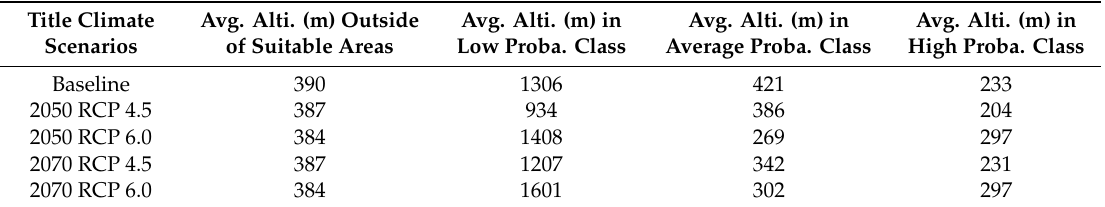
Table 3. Average altitude of polygons into the di ff erent probability classes according to baseline and future climate